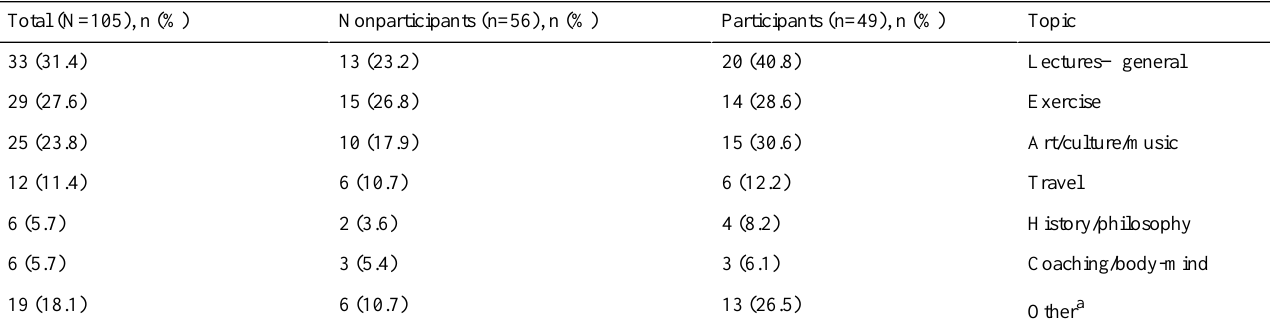
Table 4. Preferred areas of interest of participants (n=49) and nonparticipants (n=56) in web-based activities